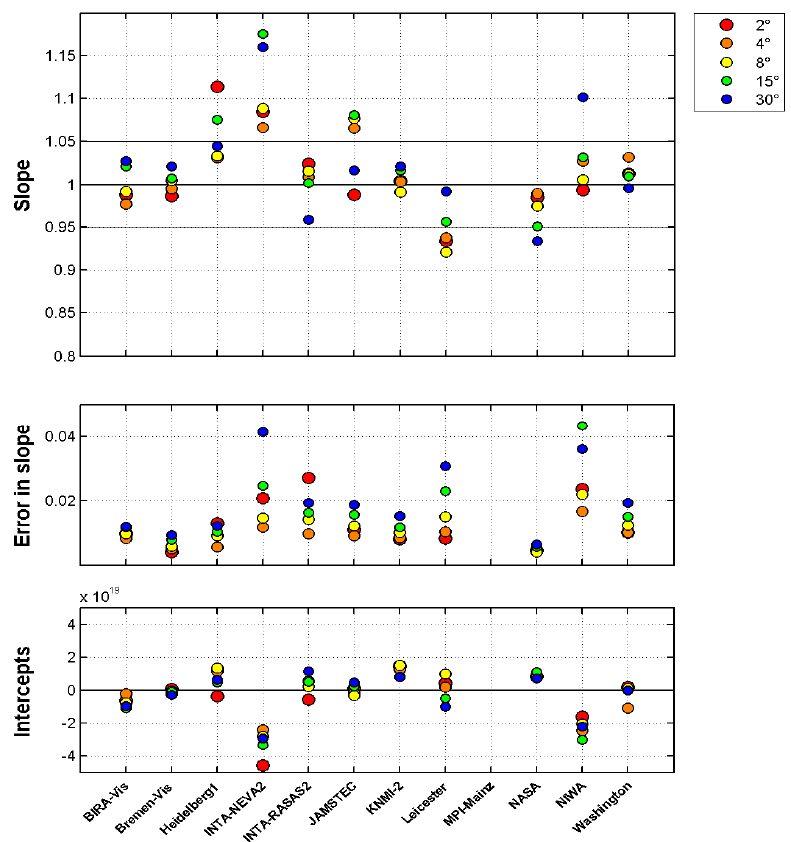
Fig. 7. Straight-line slopes and their errors of O 4 slant columns against those of the reference data set, for each instrument at visible wavelengths and for the whole campaign. Colours refer to elevation angles shown top right. MPI-Mainz used a non-standard wavelength range for analysis, which did not produce an O 4 amount.